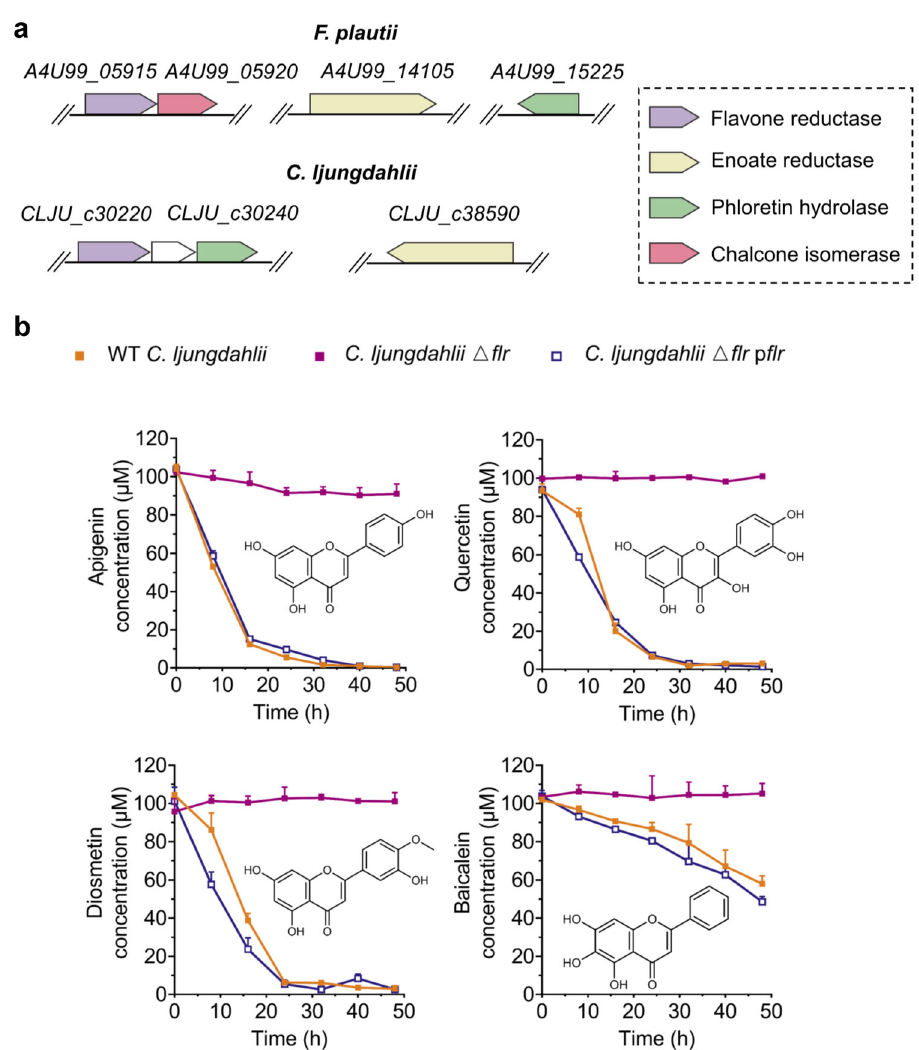
Fig. 5 Signi fi cance of fl avone reductase (FLR) in the clostridial metabolism of dietary or medicinal fl avones and fl avonols. a Homologous genes involved in the degradation of fl avones and fl avonols in F. plautii ATCC 49531 and C. ljungdahlii DSM 13528. Homologous genes are shown with same colors. b The consumption of apigenin, quercetin, diosmetin, and baicalein by the WT C. ljungdahlii (WT), C. ljungdahlii Δ fl r ( fl r deletion), and C. ljungdahlii Δ fl r p fl r (genetic complementation) strains. The WT C. ljungdahlii strain and its derived strains were grown in the YTF medium, which contained 10 g L − 1 of fructose as the extra carbon source. Data are presented as mean ± SD ( n = 3). Error bars